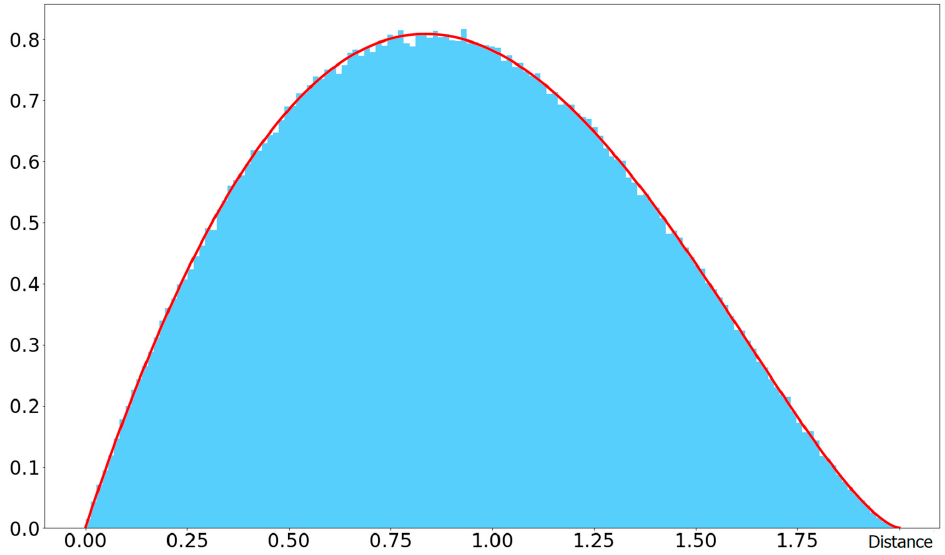
Figure 4. Distribution of distances inside a circle (R = 1). In red the graph for the density (6), in light blue a simulated distribution from values generated by a homogeneous Poisson process with density ρ = 1500 inside the